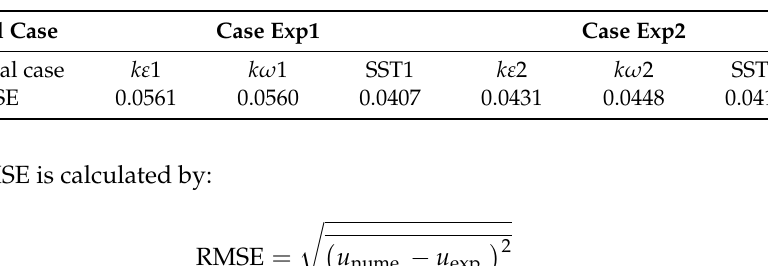
Figure 6. The wall shear stresses of three models. Table 4. Accuracy of modeling by root mean square error (RMSE in m/s).